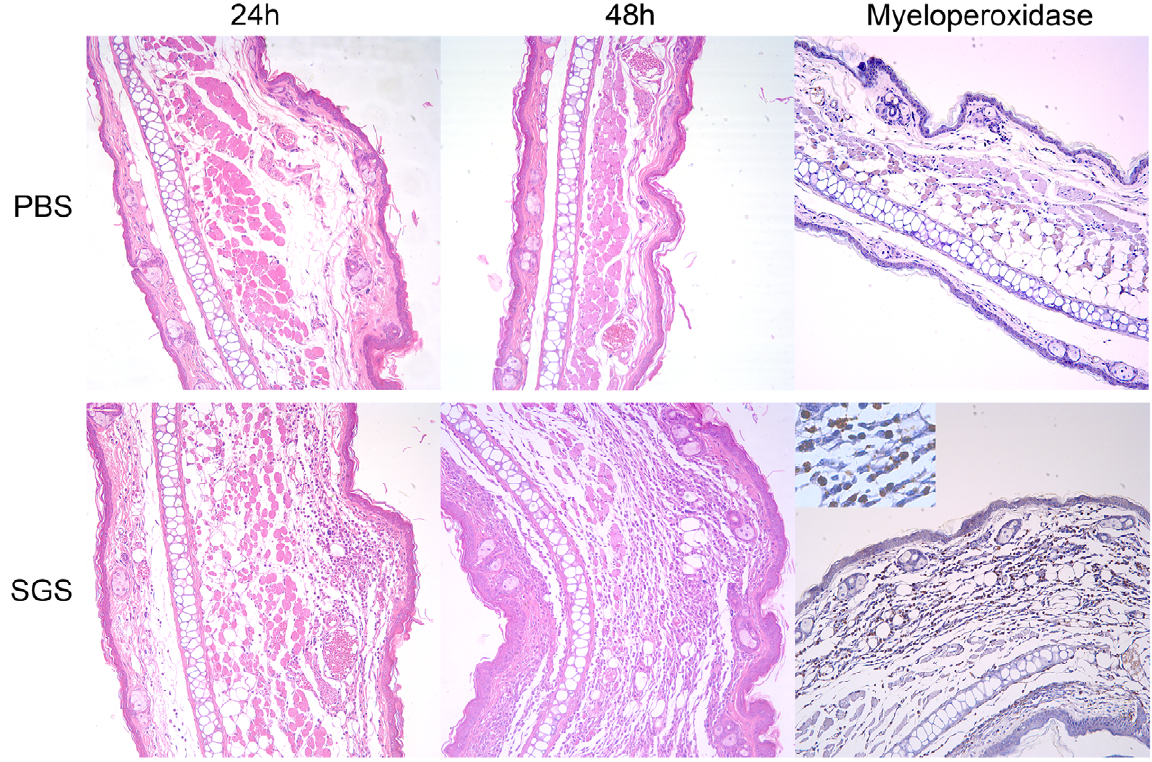
Figure 4. Enhanced neutrophil recruitment the ear dermis of mice immunized with L.intermedia saliva. Ears of BALB/c mice (five per group) were injected with PBS (control) or were immunized with L. intermedia SGS (five per group). Both groups were challenged in the contra lateral ear with L. intermedia SGS. Ear sections were obtained twenty-four and forty-eight hours after challenge and stained with H&E. Neutrophils were detected by myeloperoxidase staining at forty-eight hours after challenge with SGS. Sections were analyzed by optical microscopy under 200 6 and 400 6 magnifications (insert). Sections from one representative experiment are shown.